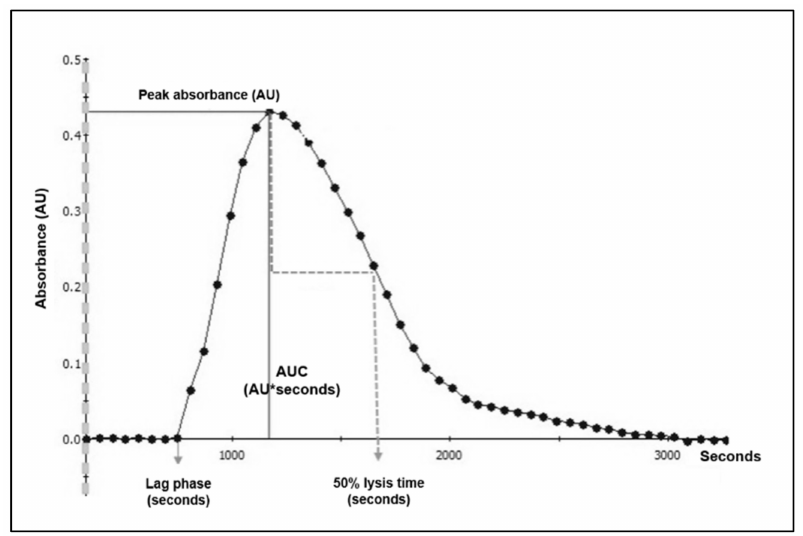
Figure 4. Example of normal fibrin clot formation and lysis curve in citrated plasma from a healthy individual. Abbreviations: AU, absorbance units; AUC, area under curve. (Modified from Larsen and Hvas, Methods and Protocols 20203(4):67 [11] (Open